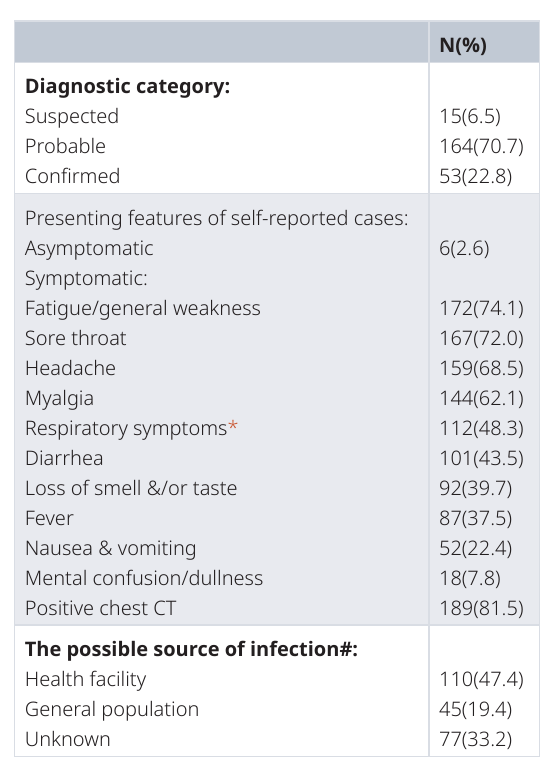
Table 4. Self-reported incidence and clinical features of COVID-19 cases.